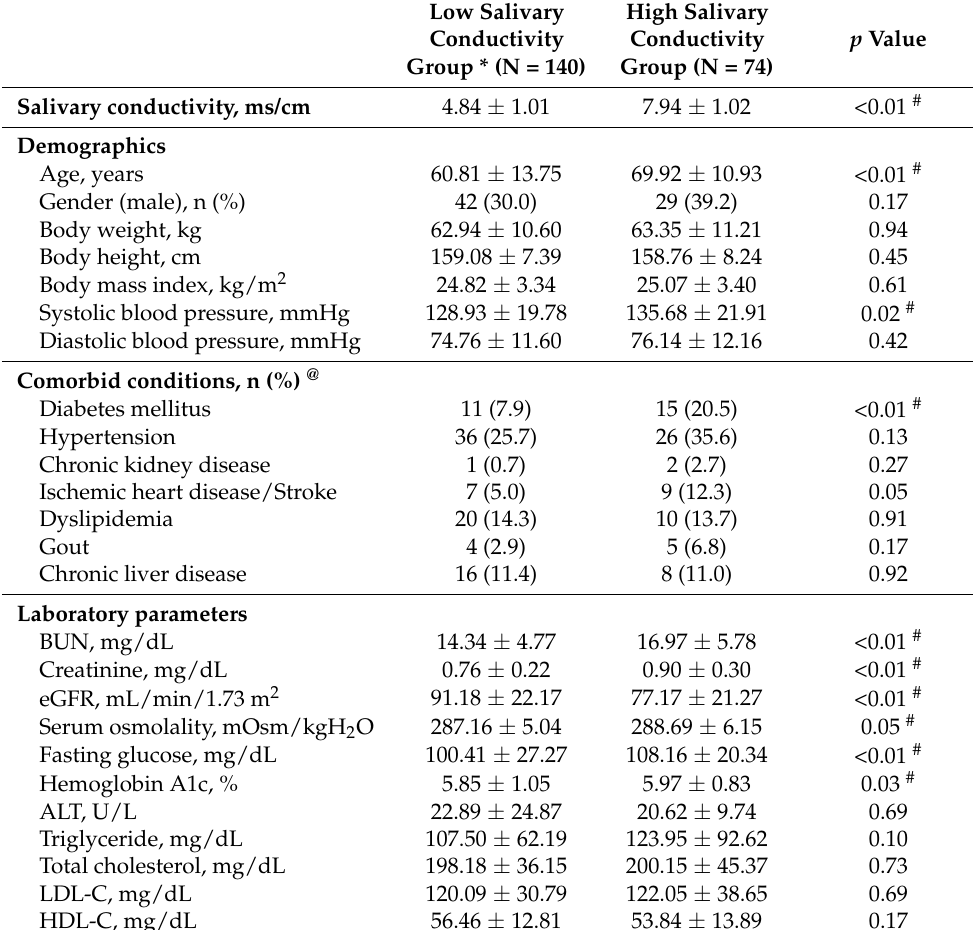
Table 3. Population characteristics of low and high salivary conductivity